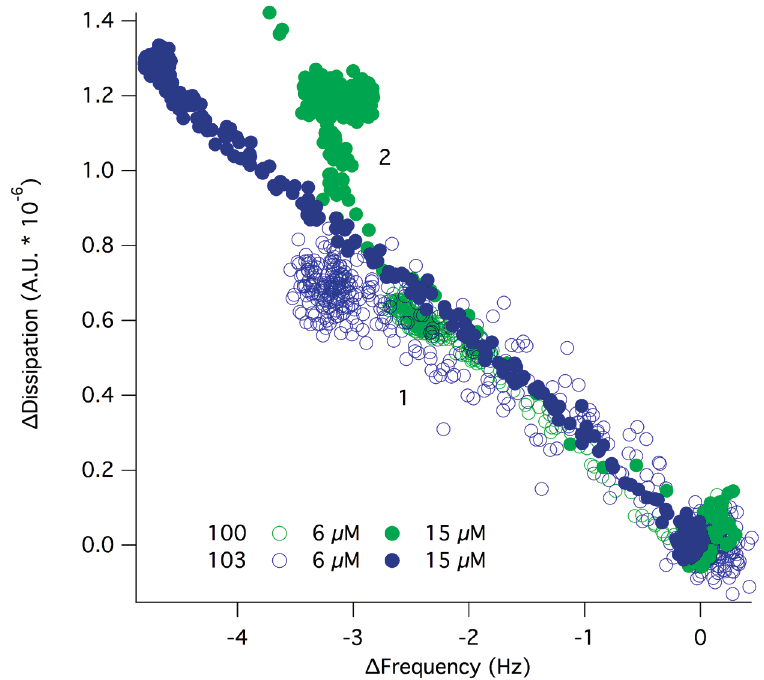
Figure 4. ∆ d plotted as a function of ∆ f for D100 (green) and D103 (blue) interacting with a POPC bilayer at 6 (open symbols) and 15 µM (filled symbols) concentration. At ∆ d, ∆ f = 0, dendrimers were added to the supported lipid bilayer. Increase in ∆ d and decrease in ∆ f indicated adsorption of dendrimers to the SLB (1). For D100 at 15 µM, there was